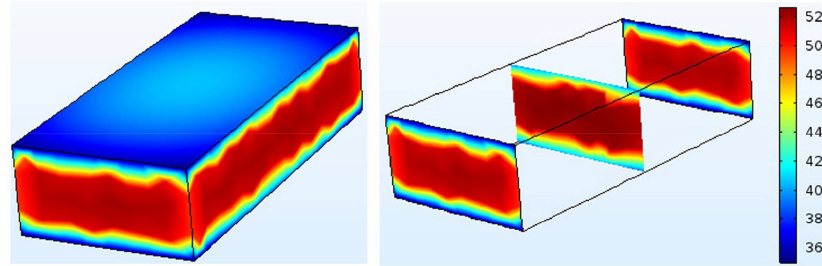
Figure 4. The temperature profile of high-frequency heating. (unit: ◦